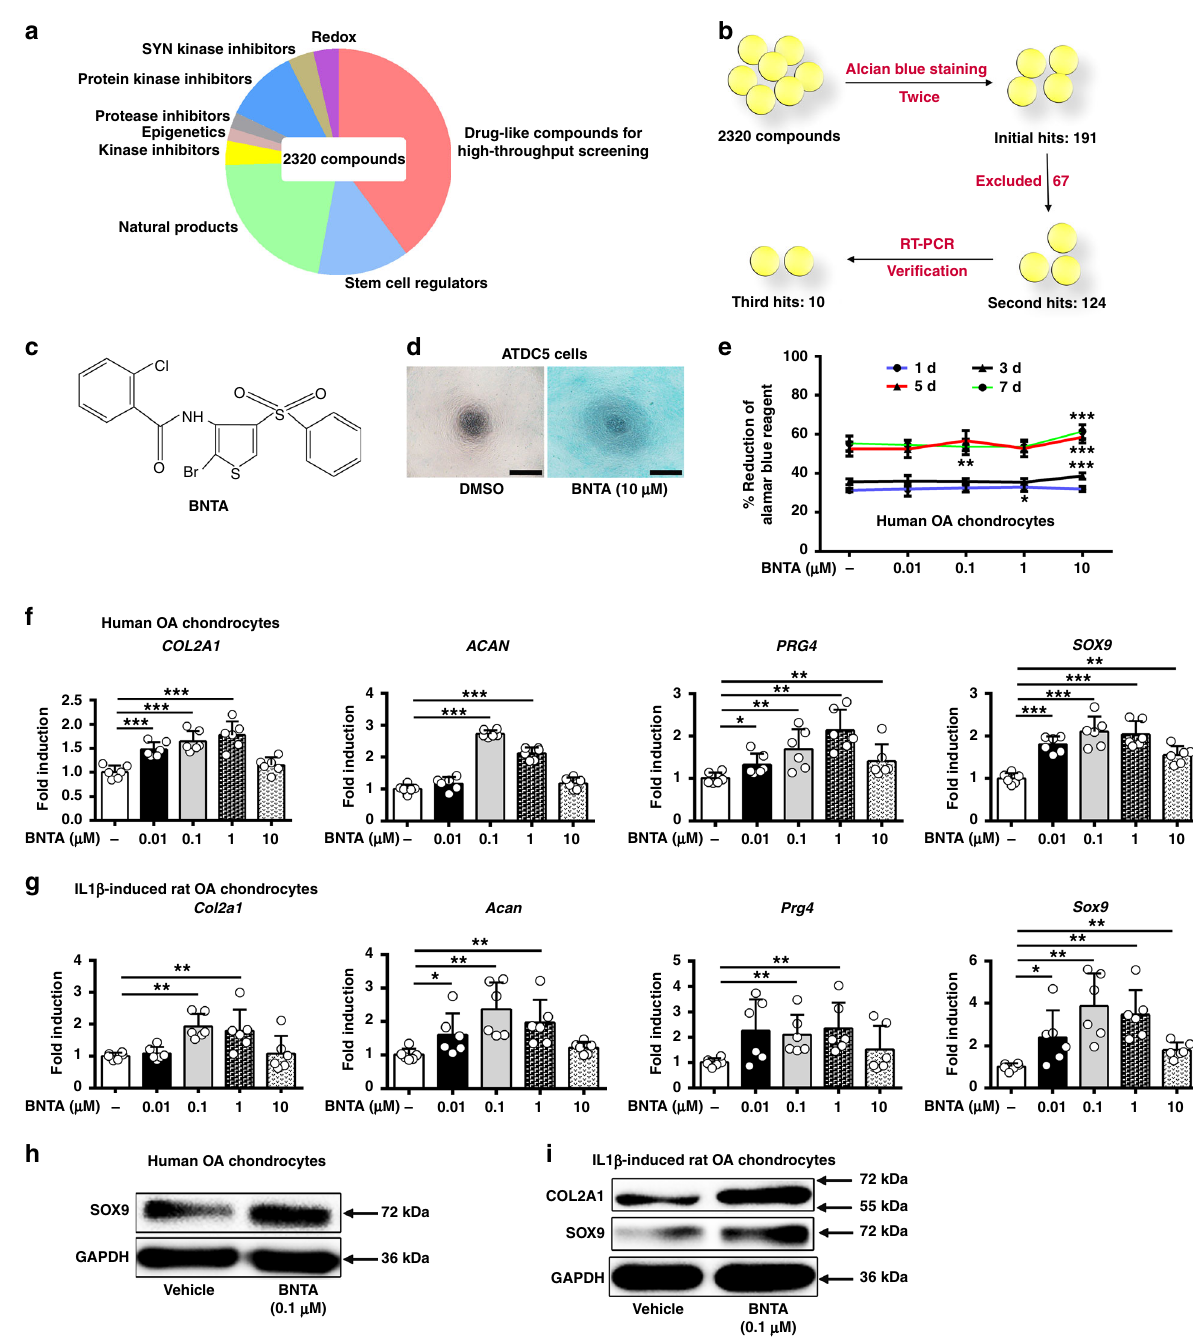
Fig. 1 BNTA was identi fi ed as a strong chondrogenic inducer that increased anabolism of chondrocytes in vitro. a Pie chart of the small compounds library used for screening in different functional groups. b Schematic diagram of screening system using alcian blue staining and reverse transcription polymerase chain reaction (RT-PCR) veri fi cation. c Structure of BNTA. d Alcian blue staining of ATDC5 cells after incubation with BNTA or DMSO (vehicle) at 10 μ M for 5 d ( n = 3; three independent experiments; scale bars, 400 μ m). e Cell viability of human osteoarthritis chondrocytes assessed using the alamar blue assay at 1 d, 3 d, 5 d, and 7 d after BNTA treatment ( n = 14 for each group; 1 d, nonparametric test; 3 d, 5 d, and 7 d, one-way ANOVA). f Quanti fi cation of mRNA levels for collagen type II alpha 1 chain ( COL2A1 ), aggrecan ( ACAN ), proteoglycan 4 ( PRG4 ), and SRY-box 9 ( SOX9 ) in human OA chondrocytes treated with BNTA for 6 h. Fold changes relative to vehicle control are shown ( n = 6 for each group; COL2A1 , ACAN , SOX9 , one-way ANOVA; PRG4 , nonparametric test; three independent experiments). g The mRNA levels of Col2a1 , Acan , Prg4 , and Sox9 in interleukin 1 beta (IL1 β , 10 ng ml − 1 )-induced rat OA chondrocytes treated with BNTA for 6 h ( n = 6 for each group; Col2a1 , one-way ANOVA; Acan , Prg4 , and Sox9 , nonparametric test; three independent experiments). h The proteins levels of SOX9 and glyceraldehyde-3-phosphate dehydrogenase (GAPDH) in human OA chondrocytes treated with vehicle or BNTA (0.1 μ M) for 2d. i The proteins levels of COL2A1, SOX9, and GAPDH were detected using western blotting assay in IL1 β (10 ng ml − 1 )-induced rat OA chondrocytes treated with or without BNTA (0.1 μ M) for 2d. All data are shown as the mean ± standard deviation (s. d.). * P < 0.05, ** P < 0.01, *** P < 0.001. Source data are provided as a Source Data fi